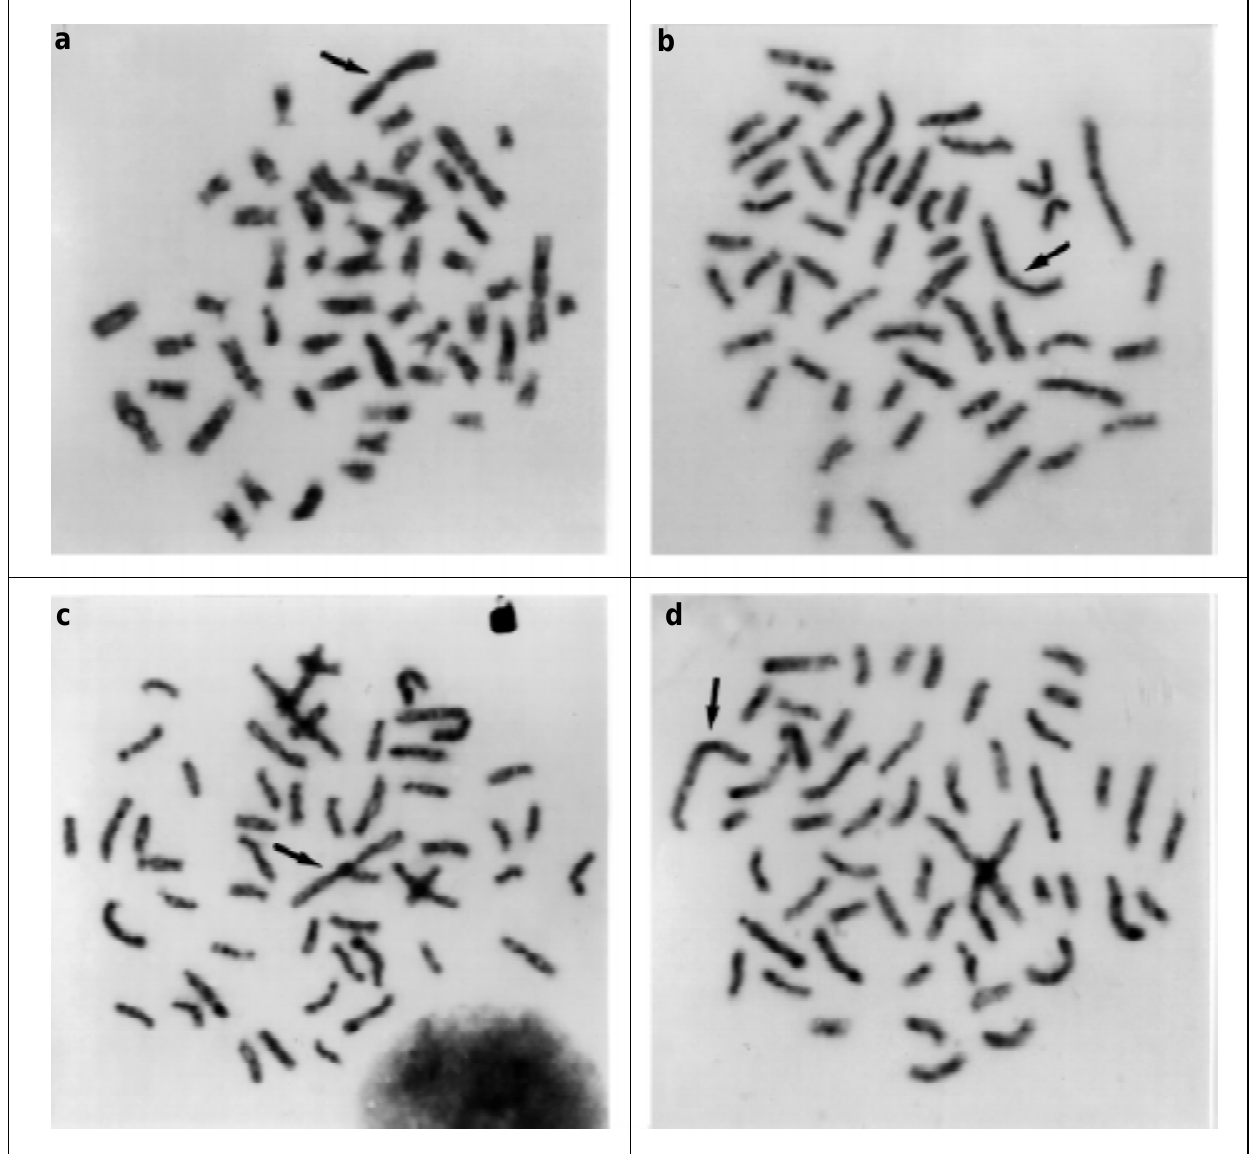
Figure 1 - Somatic metaphase chromosomes of Astyanax scabripinnis paranae submitted to different banding procedures: (a) replication banding pattern (R-band) after treatment with 5-BrdU; (b) G-banding pattern obtained after trypsin treatment; (c) G-banding pattern obtained after chromosome cleavage by in situ treatment with the restriction endonuclease Bam HI, and (d) similar G-banding pattern obtained after cleavage with the restriction endonuclease Hin fI. Arrows mean probable